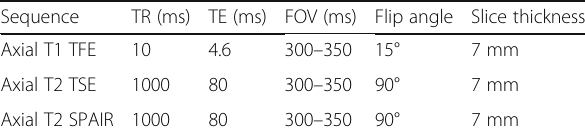
Table 1 The parameters of pre contrast sequences